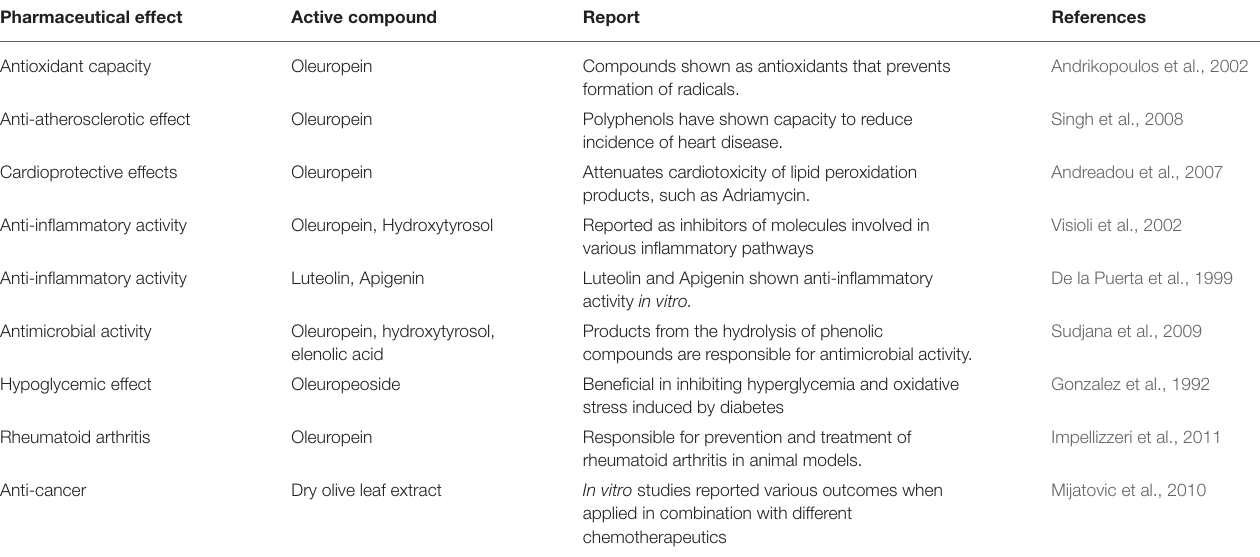
TABLE 5 | Active compounds in olive leaf extract and their reported pharmaceutical